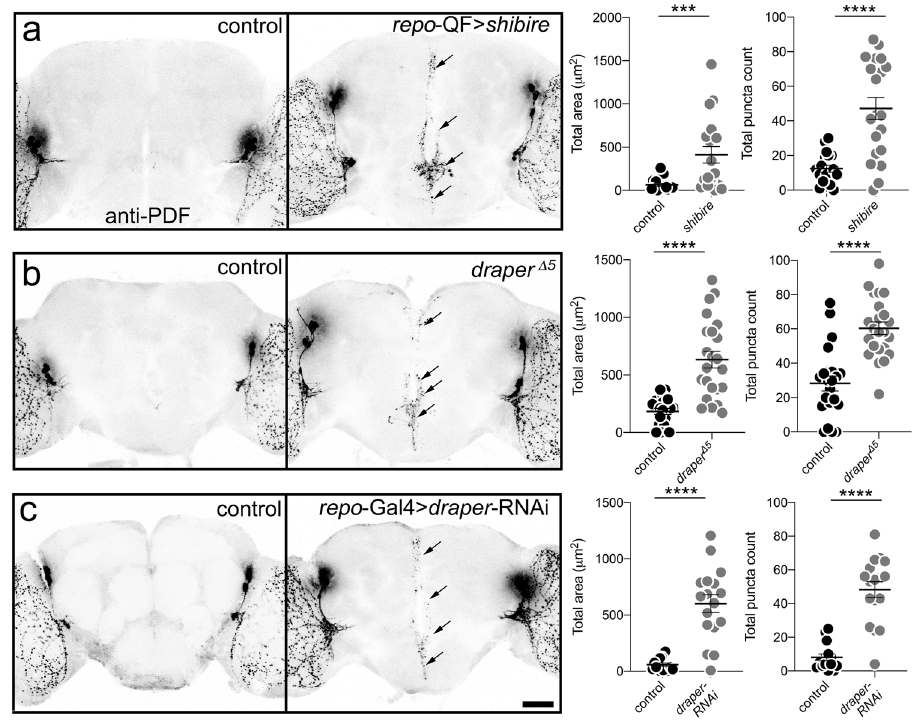
Fig. 2 Central PDF-Tri neuron elimination requires Draper-dependent glial clearance. a Whole brains labeled with anti-PDF in transgenic glial driver control ( repo -QF/ + , left) and with dominant-negative shibire ts expressed in glia ( repo -QF > shibire ts , right). PDF-Tri neurons (arrows) absent in controls, but persist when glial phagocytosis is blocked. Brains at 2 DPE, raised at 30 °C. Right: Graphs showing central PDF-Tri area (left) and PDF + puncta (right) in the two genotypes. Area: Two-sided Mann – Whitney, p = 0.0006, 63.52 ± 17.21 n = 18 control, 412.3 ± 95.91 n = 19 glial shibire ts . Puncta: Two-sided t test, p < 0.0001, 12.42 ± 2.012 n = 19 control, 47.15 ± 6.34 n = 20 glial shibire ts . b Brains labeled with anti-PDF in genetic background control ( w 1118 ) and draper null ( draper Δ 5 ). PDF-Tri neurons absent in controls, but persist when Draper activity is blocked. Brains at 5 DPE, raised at 25 °C. Right: Graphs show anti- PDF area (right) and PDF + puncta (left). Area: Two-sided t test, p < 0.0001, 183.1 ± 26.78 n = 21 control, 631 ± 71.56 n = 23 draper . Puncta: two-sided Mann – Whitney, p < 0.0001, 28.36 ± 4.385 n = 22 control, 60.26 ± 3.661 n = 23 draper . c PDF-labeled brains in transgenic control ( repo -Gal4/ + ) and with draper -RNAi in glia ( repo -Gal4 > draper -RNAi). Right: Graphs show anti-PDF area (right) and puncta (left). Area: two-sided t test, p < 0.0001, 58.24 ± 14.41 n = 16 control, 602.03 ± 78.46 n = 17 draper -RNAi. Puncta: Two-sided t test, p < 0.0001, 8 ± 2.04 n = 15 control, 48.24 ± 4.746 n = 17 draper -RNAi. Scatter plot graphs show mean ± SEM. Sample size is n = number of animals. Signi fi cance shown for p < 0.001 (***) and p < 0.0001 (****). Scale bar: 50 μ m. Source data for this fi gure are provided in Source Data fi